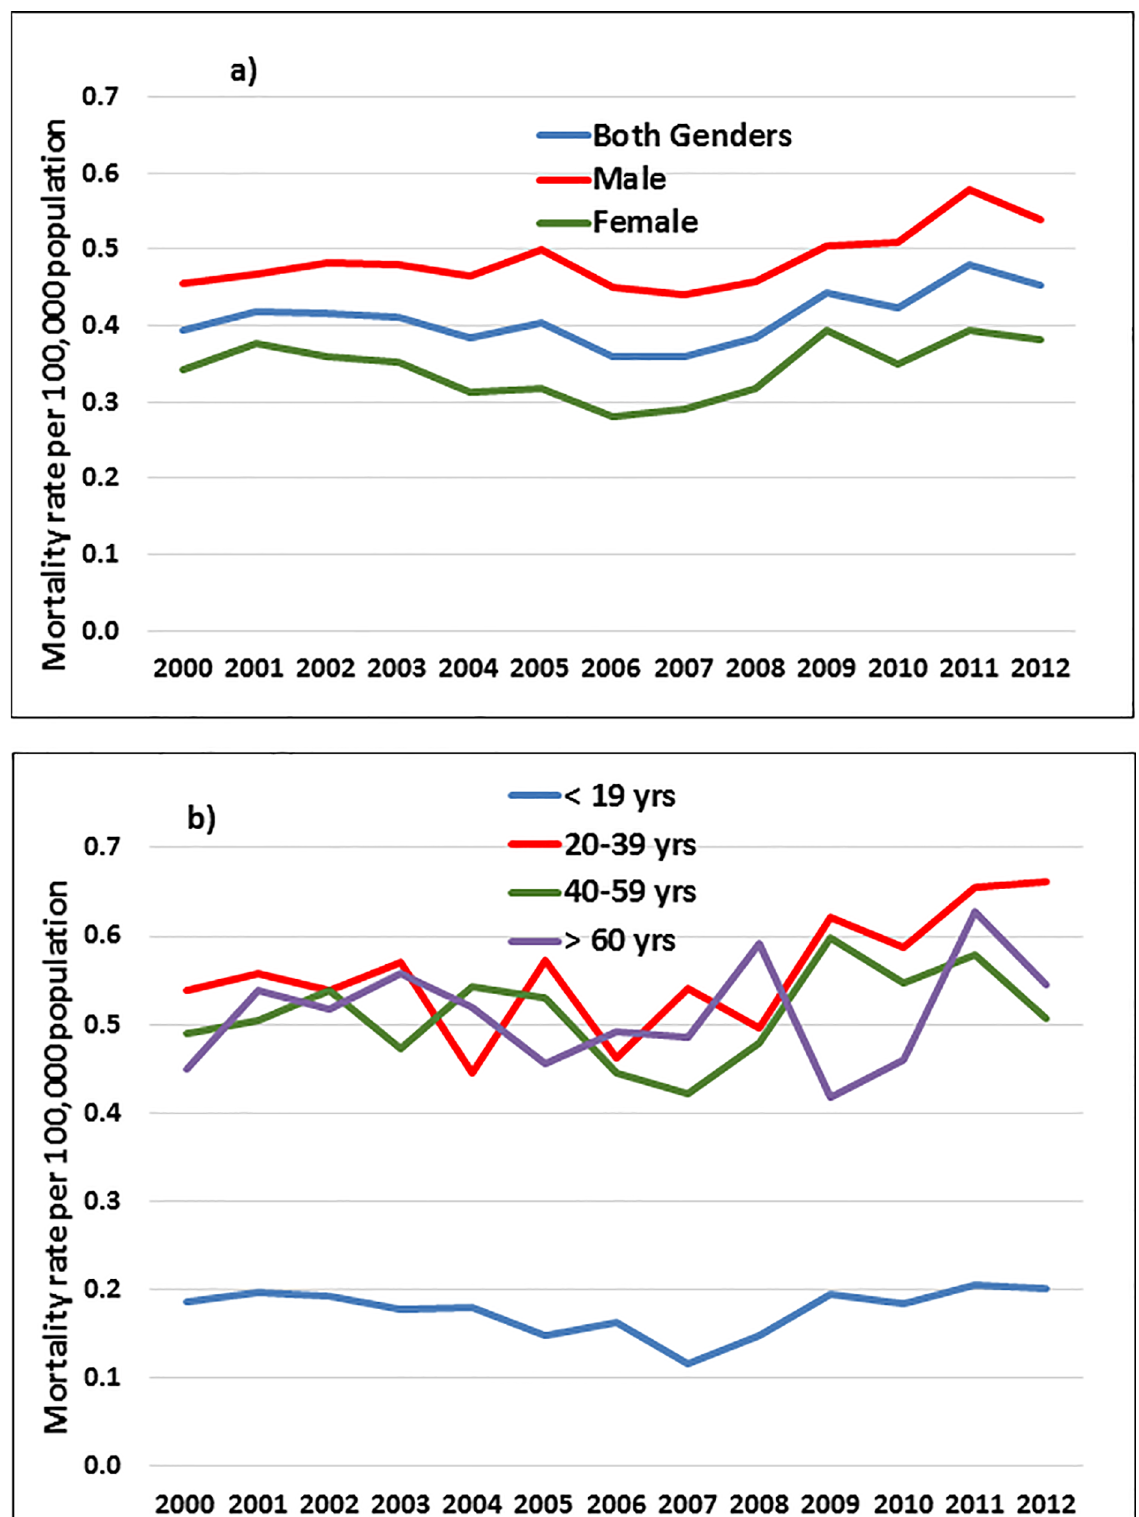
Fig 2. Self-poisoning mortality in Mexico by a) gender and b) age group.